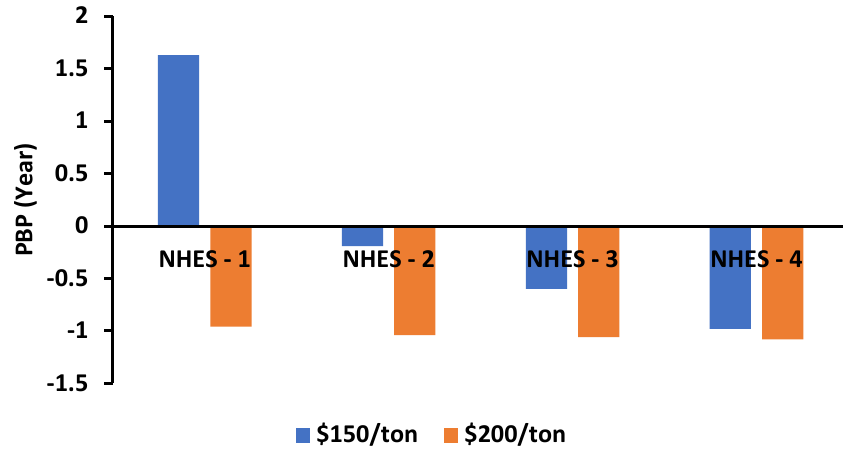
Figure 20. Difference in PBP based on increased carbon tax for Midwest region.